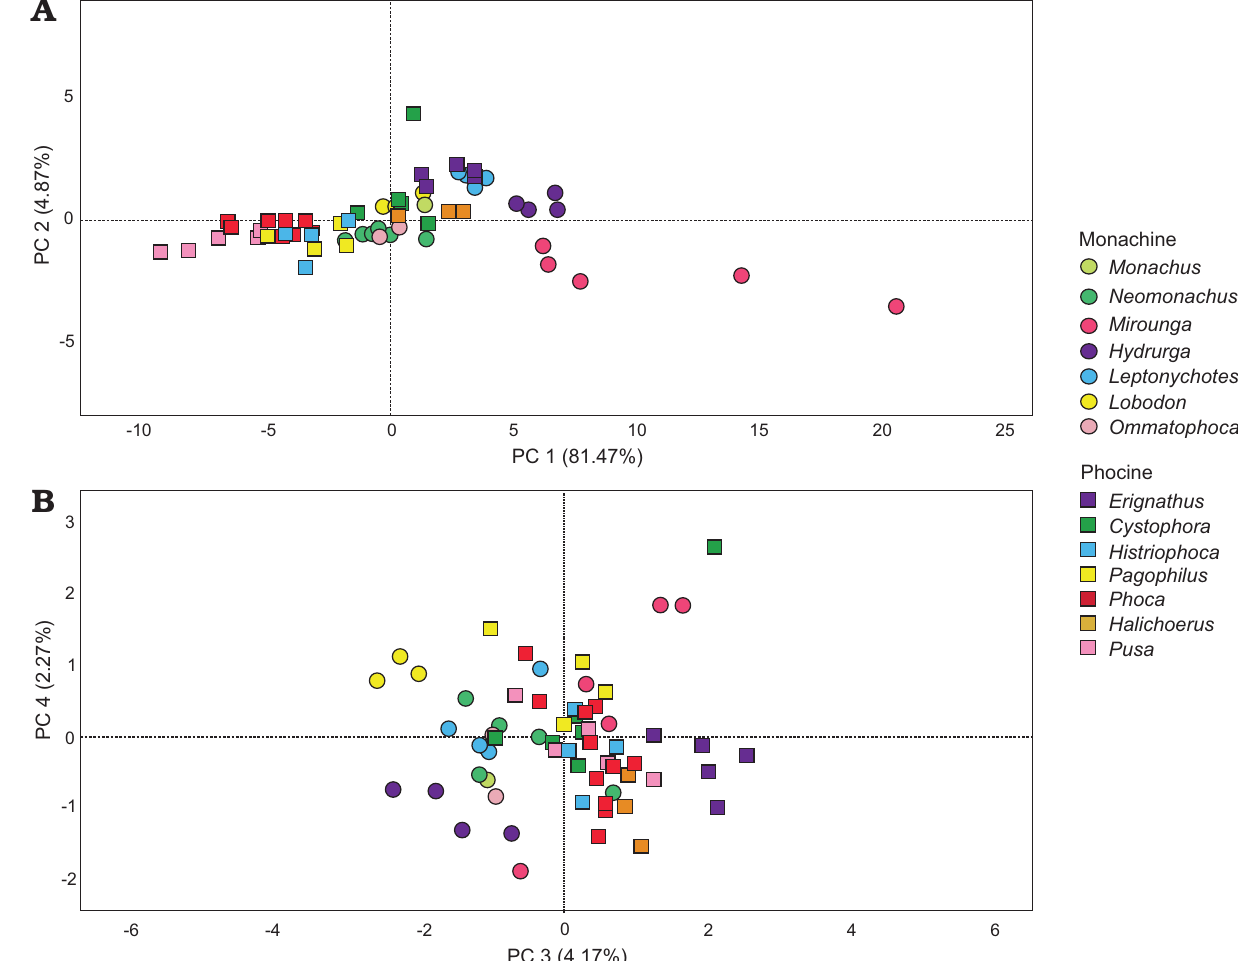
Fig. 2. Results of PCA for the combined dataset of both humeral and femoral measurement data, for extant earless seal taxa. A . PC1 vs. PC2. B . PC3 vs.